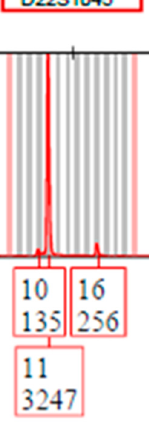
Figure 4. Extreme peak height imbalance possible with single cell analysis illustrated with the locus D22S1045. The known genotype of the cell donor is 11, 16 (10 = back stutter). Model Maker performance DSCS versus standard bulk analysis was compared by plotting the log(Hb) vs. Average Peak Height of single source bulk or single cell samples (Figure 5) with the dashed red lines indicating the 95% bounds (+/ − 2 standard deviation of the mean) calculated using Equation (5). 𝐶 (cid:2870) (5) (cid:3399)√2 × 1.96(cid:3496) 𝐴𝑃𝐻 C 2 = the 50th percentile of the allelic peak height variance Utilizing a normal distribution, 87.6% of the single source cell data fell within the 95% bounds. Ideally ≥ 95% of the data would have been encapsulated within the 95% bounds. A comparison of Figure 5A and B shows that the 95% bounds for the DSCS sam- ples are much broader than standard analysis parameters to account for the low template and stochastic effects seen with single cells (i.e., the extreme peak height imbalance). Figure 5. DSCS peak height variability ( A ) Standard Analysis ( B ) DSCS. DSCS results in a broader distribution due to the increased variance/peak height imbalance due to low template effects. 3.6. Post Burn-In Accepts With STRmix TM , various post burn-in accepts (5000, 50,000, and 500,000) were tested 5× with a single source three-cell subsample (Figure 6). As the number of burn-in accepts increases, so does the time required for analysis as well as the precision of the LR results. STRmix TM default setting is 50,000 burn-in accepts. However, when analyzing single cell subsamples, the most consistent log (LR) results occurred at 500,000 post burn-in accepts.